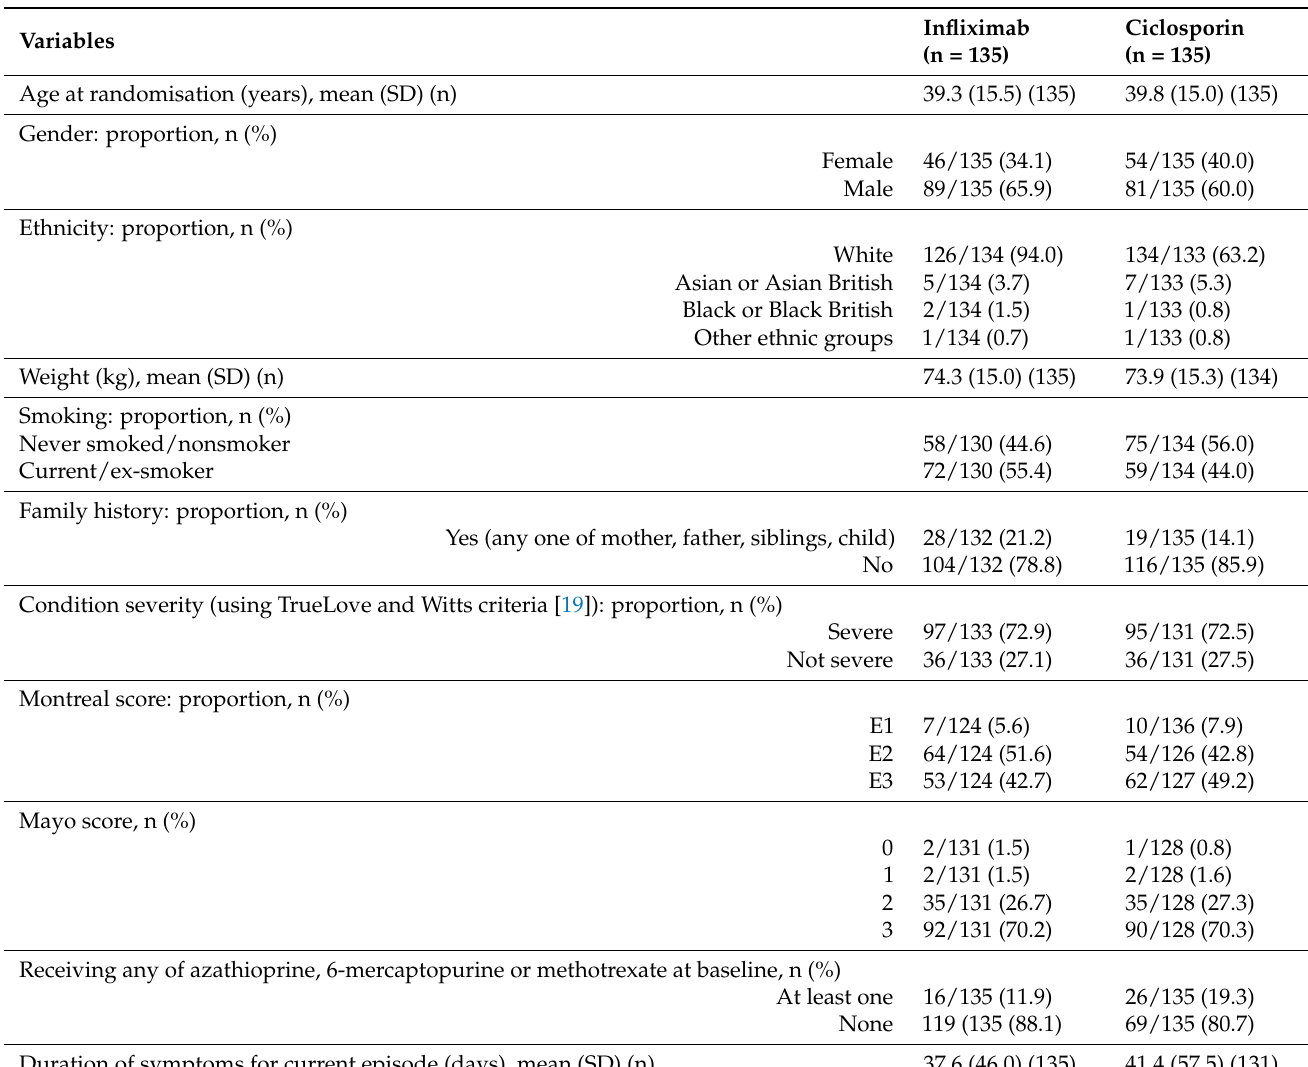
Table 1. Baseline characteristics of recruited patients in the infliximab and ciclosporin treatment groups